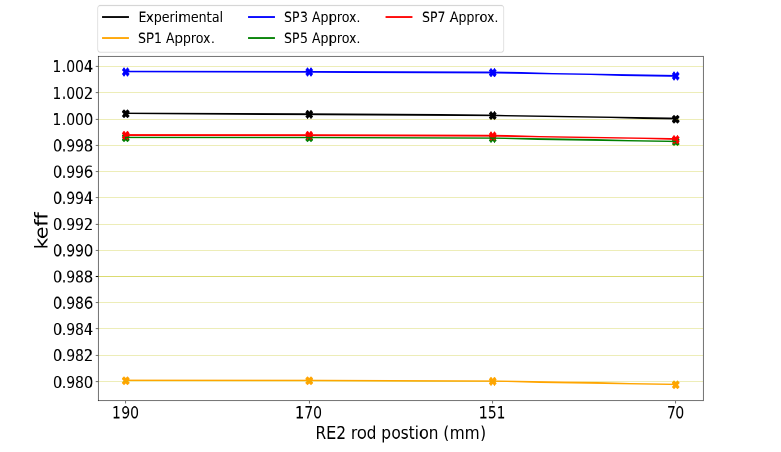
Figure 5. k ef f values obtained with AZNHEX- SP L and their comparison with the experimental